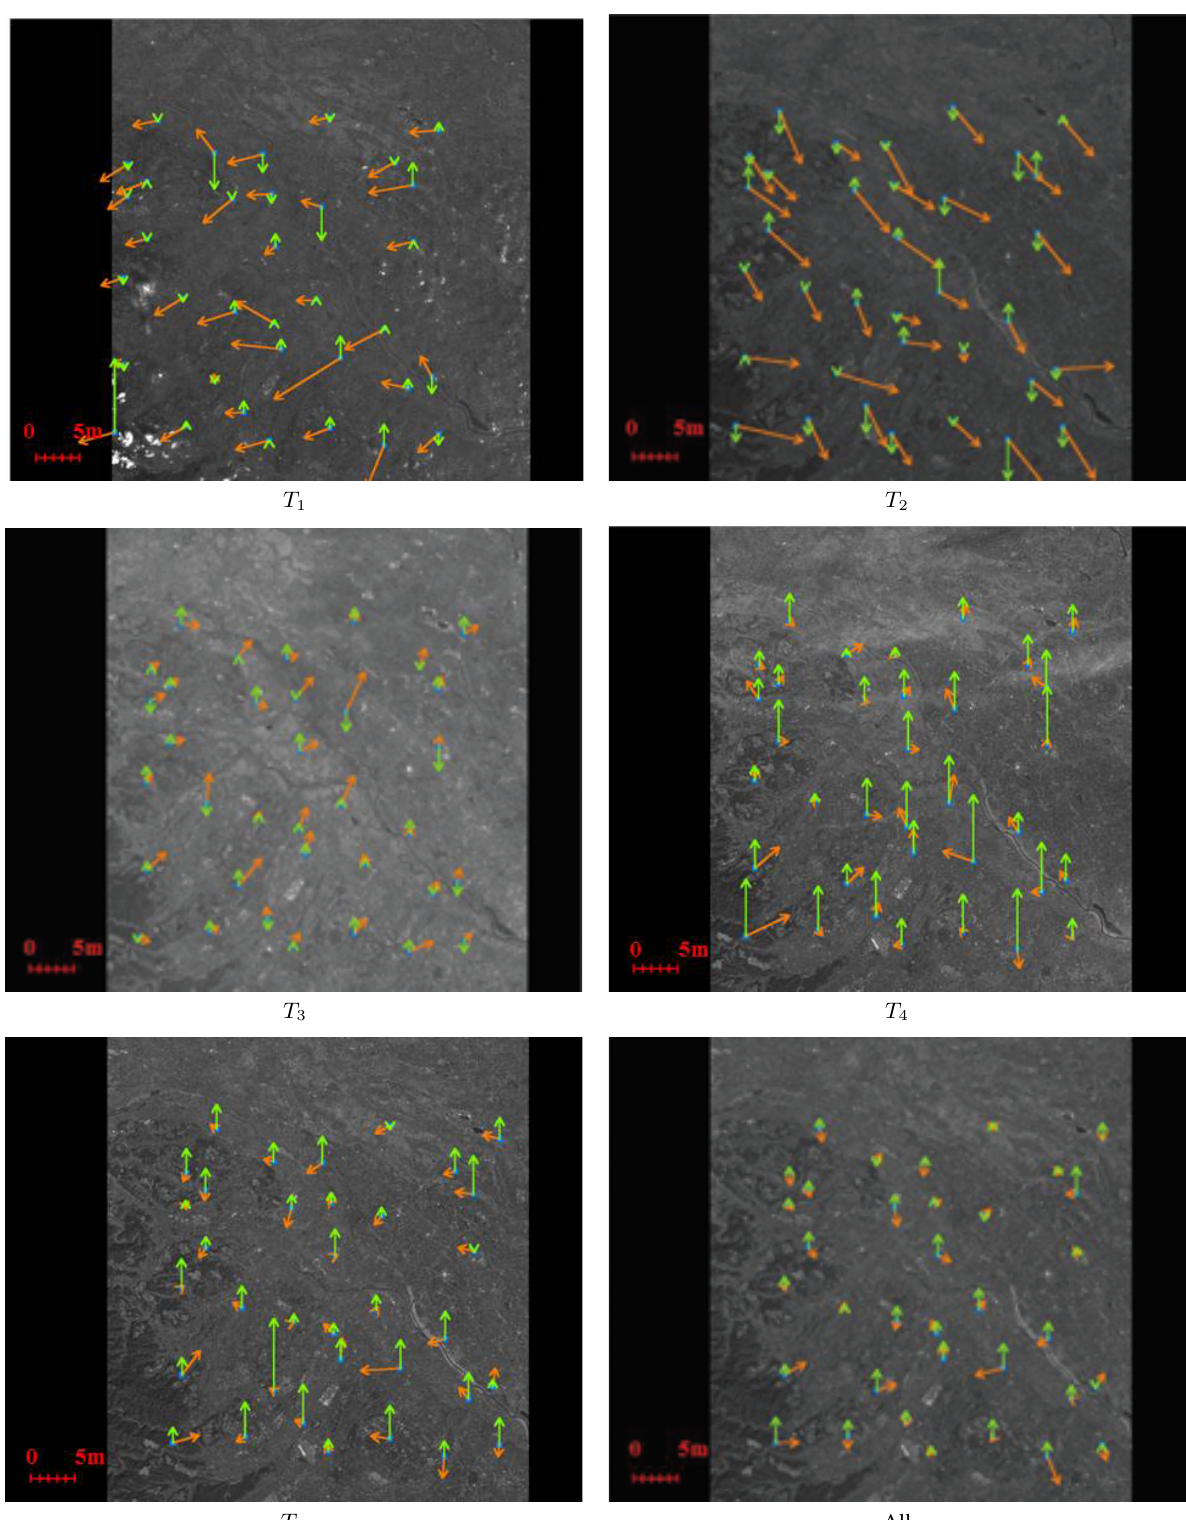
Figure 1. RMSE of coordinates estimated by using the standard RPC model without bias correction. Brown and green arrows denote planimetric and height errors,